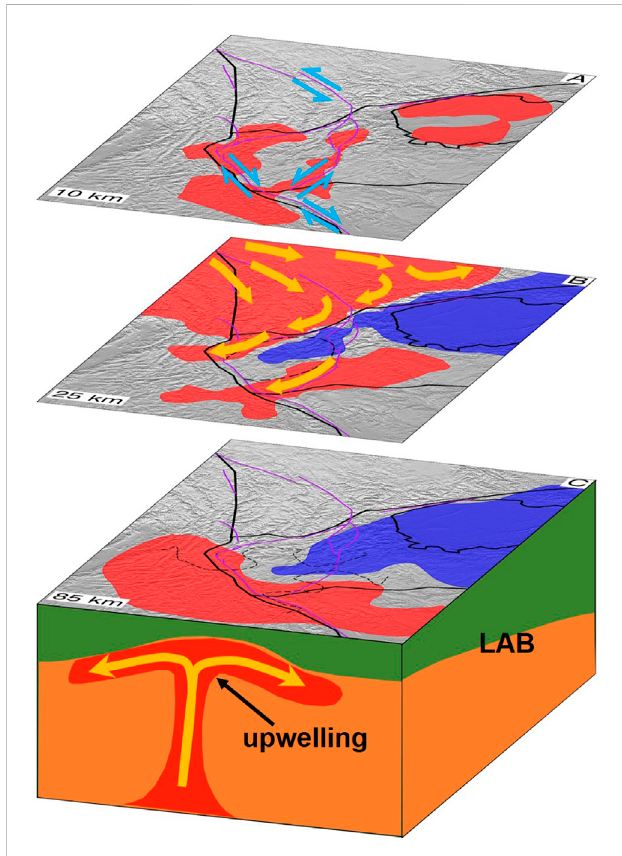
FIGURE 11 Schematic model for the possible deformation mechanisms at different depth ranges (A – C) in the southeastern Tibetan Plateau. Thick colored arrows represent the possible movement direction of blocks (blue) or materials (yellow). Red and blue areas mark the low- and high-velocity bodies, respectively. Black dashed lines in (B) and (C) mark the inner zone of the ELIP and lithospheric thickness less than 100 km, respectively. Purple and black lines represent the main faults and